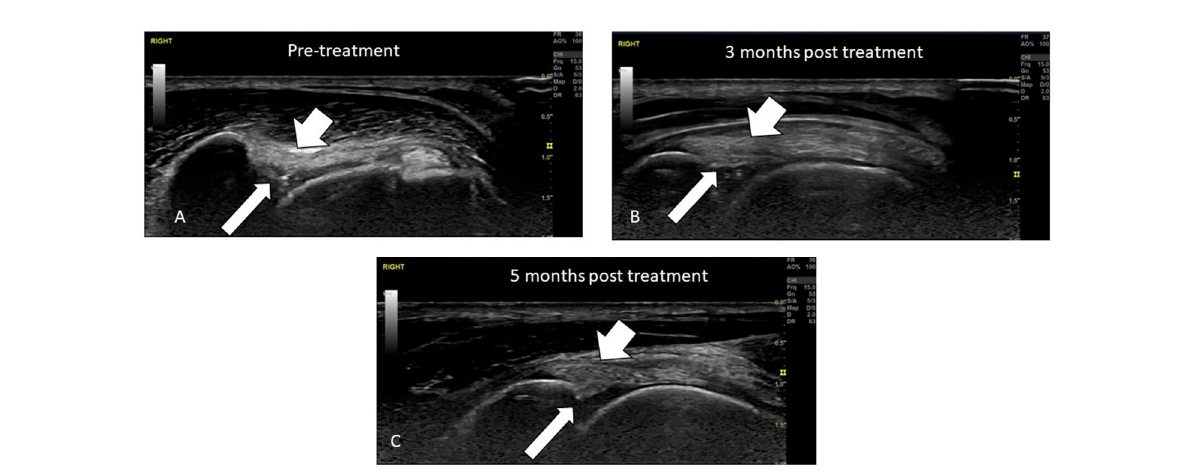
FIGURE5 Ultrasound evaluation of a Biceps tendinopathy and partial Subscapularis tendon tear in 4-year-old agility dog before and after treatment with RM. The long arrows point to the position of the Subscapularis tendon and the short arrow the Biceps tendon. (A) Pre-treatment the Biceps tendon has extensive fibrosis and loss of a linear fiber pattern and enthesis and the Subscapularis tendon is partially torn with free floating fibers and fibrotic proliferation. (B) 3 months following treatment the Biceps tendon has shown extensive healing with a reduction in fibrosis and restoration of a more normal linear fiber pattern. The integrity of the Subscapularis tendon has improved but complete healing has not been achieved. A second treatment of MSCs was implanted. (C) 5 months following initial treatment and 2 months after the second treatment. The fiber patterns have improved with resolution of fibrotic infiltration, the biceps enthesis is normal and the integrity of the subscapularis has been restored.